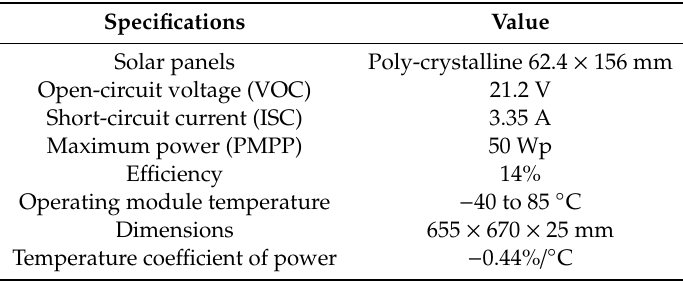
Table 1. Len 50 Wp solar module